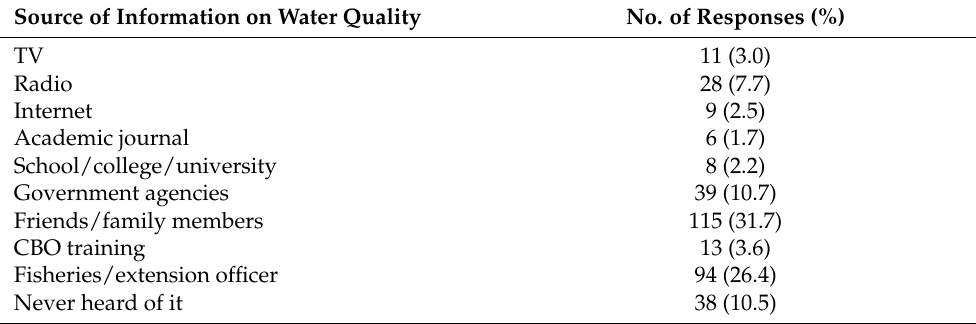
Table 4. Frequencies of sources of information on water quality management among fish farmers of the Rwenzori region, Uganda. These frequencies were obtained for multiple responses. CBO stands for community-based